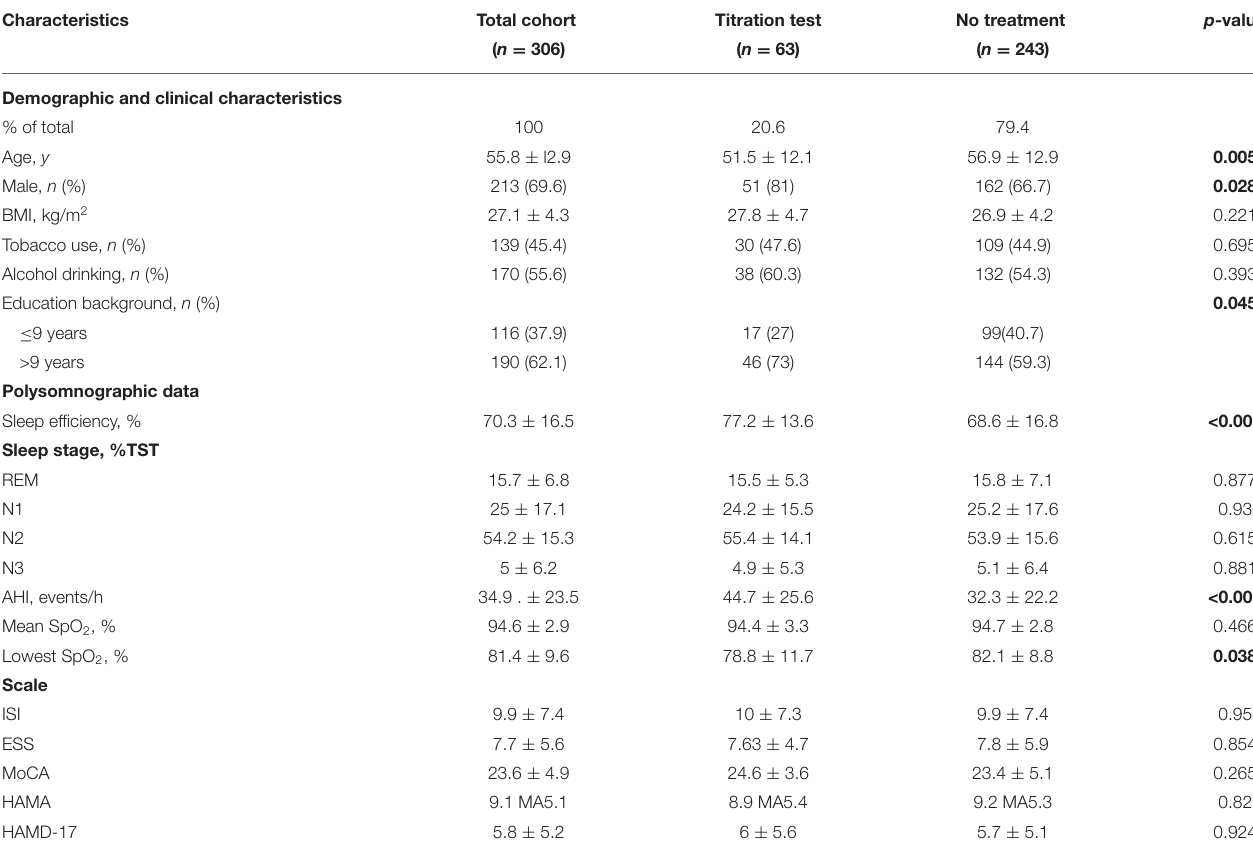
TABLE 2 | Characteristics of the patients according to the treatments for OSA.